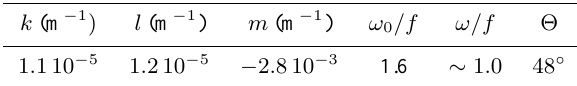
Table 1. Gravity wave packet